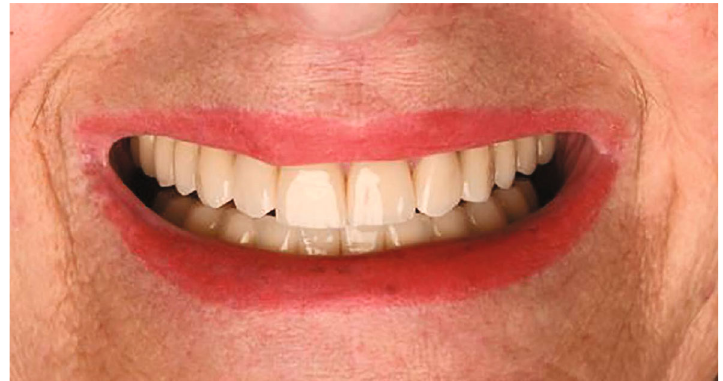
Figure 11: Patient ’ s